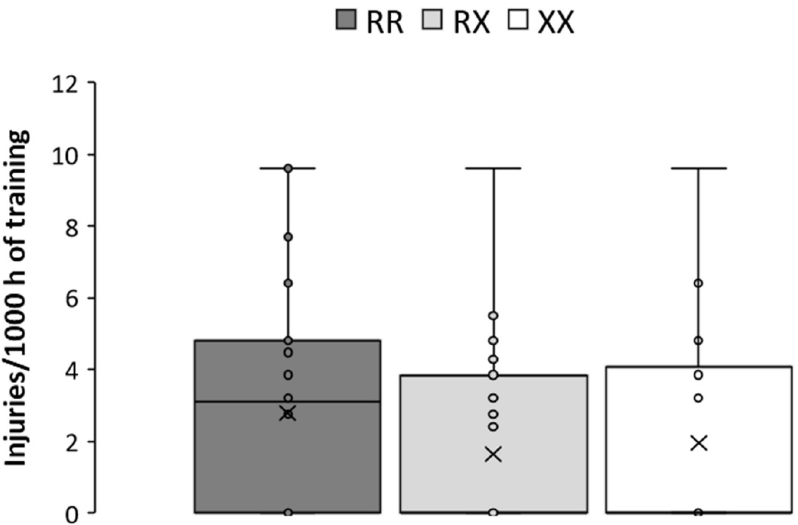
Fig 1. Box-and-whisker plots for injury rates in ACTN3 RR, RX and XX amateur marathon runners. The cross depicts the mean value while the lower, middle and upper lines of the box represent the 25%, 50% and 75% percentile. Whiskers represent 1.5 × interquartile range.